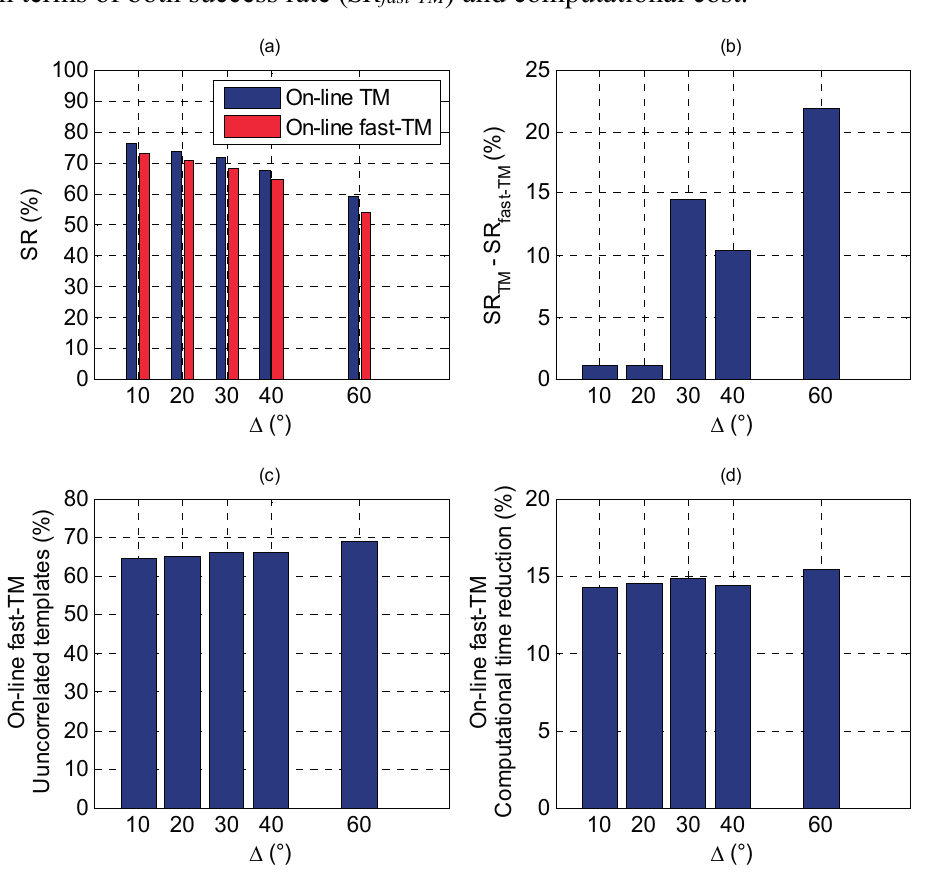
Figure 7. On-line TM vs . on-line fast-TM. ( a ) Success rate; ( b ) Loss of success rate of the on-line fast-TM; ( c ) Percentage of templates excluded from the correlation function evaluation; ( d ) Computational time